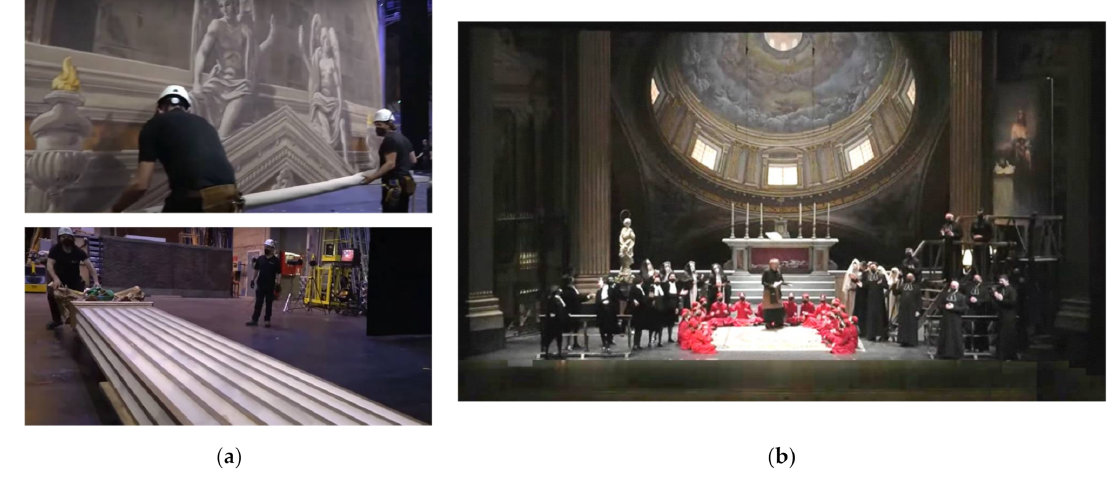
Figure 8. Act I of Tosca at the Teatro Massimo of Palermo (2022): installation ( a ) and final scenery during the performance ( b ).